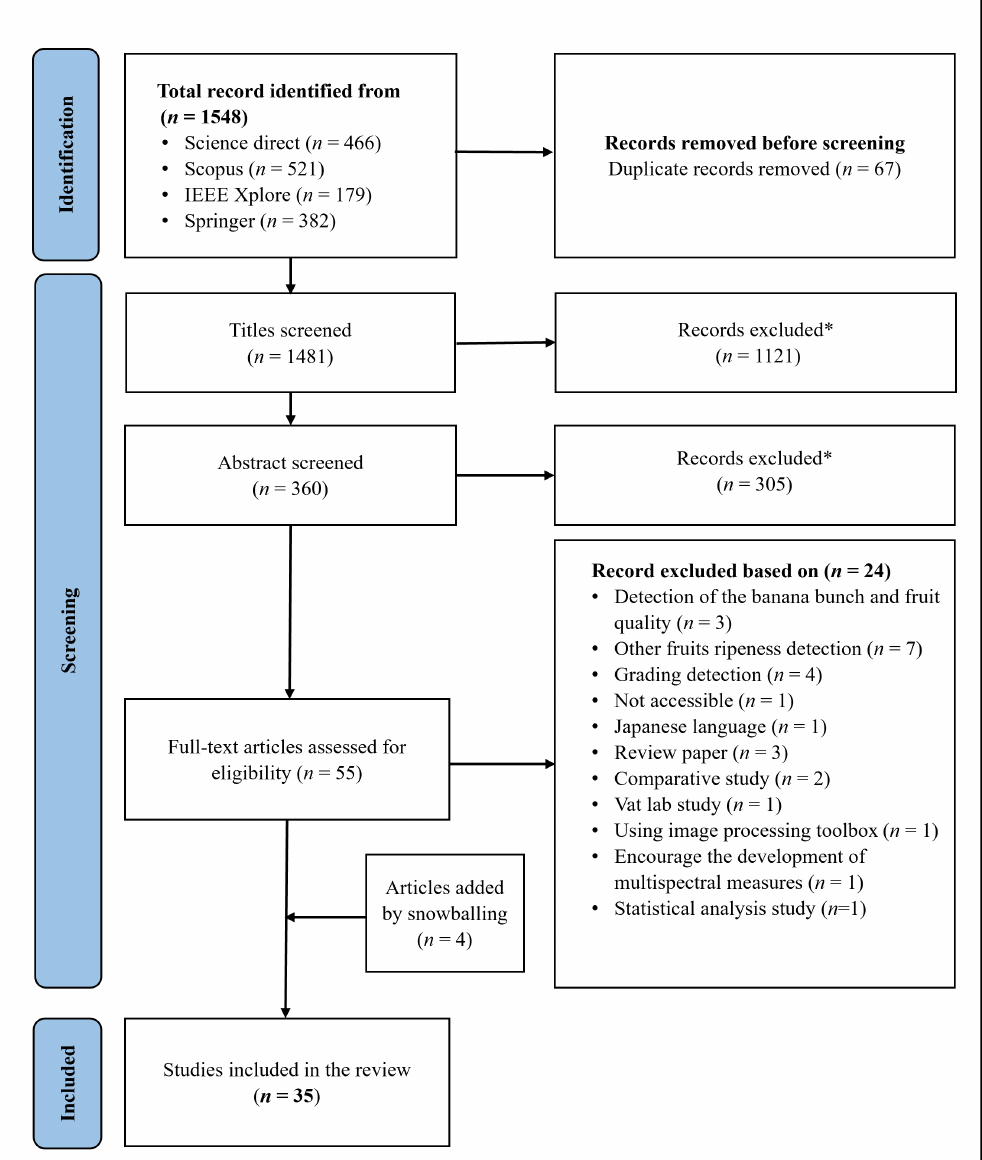
Figure 1. PRISMA flow diagram for banana